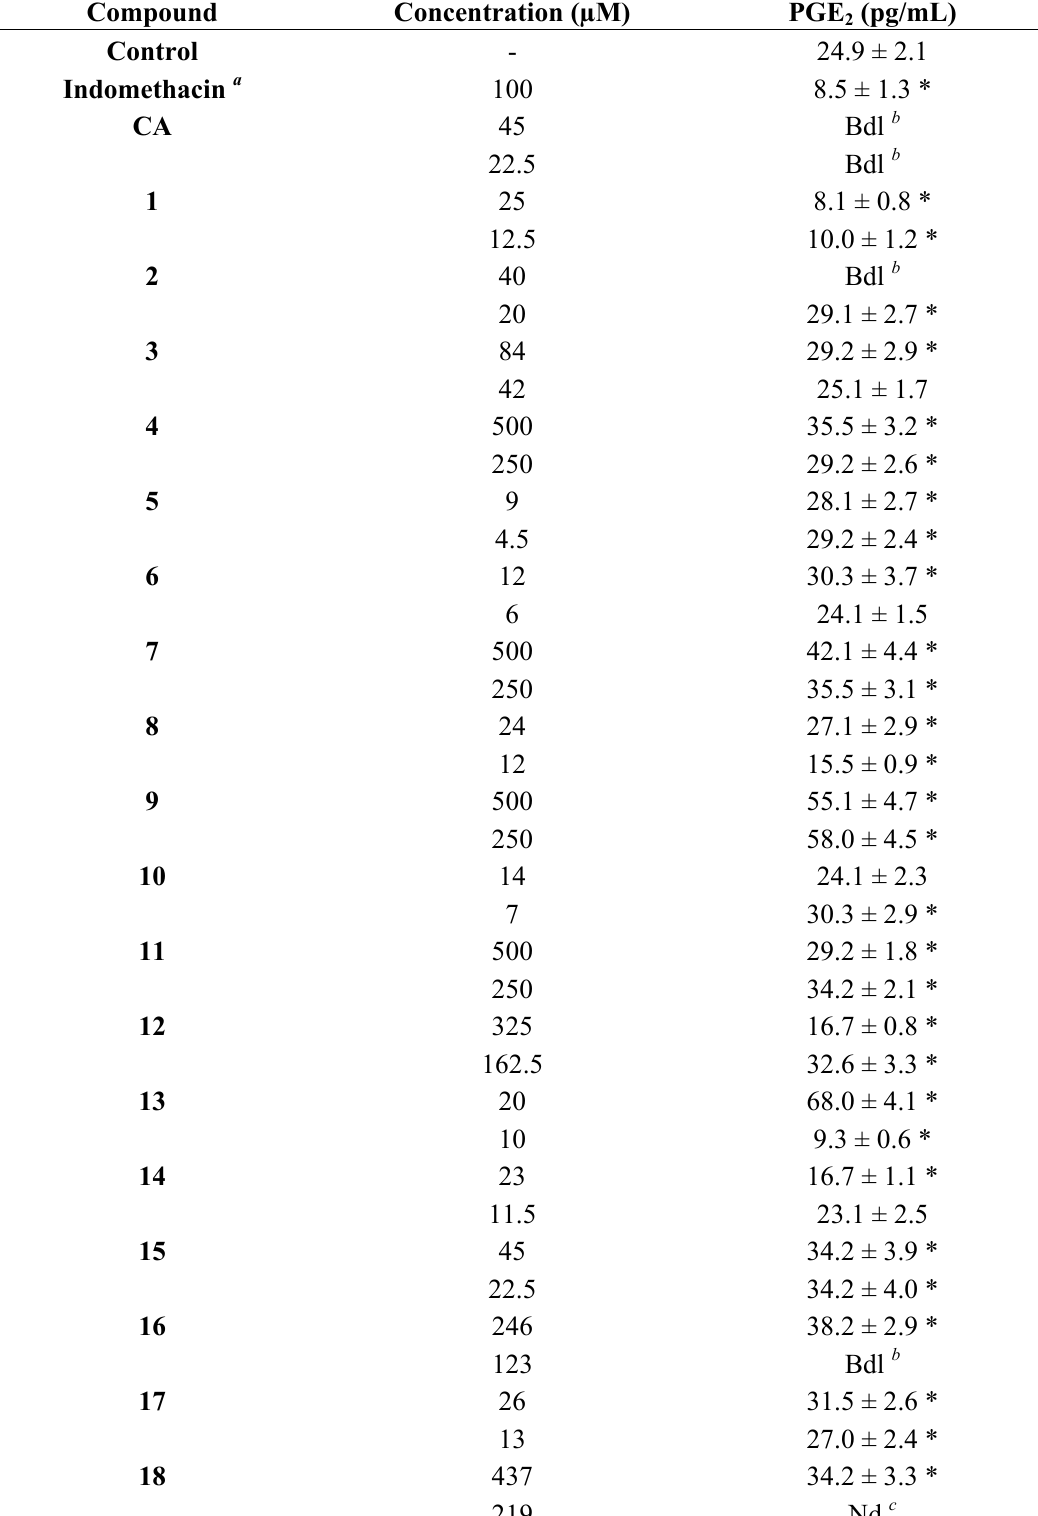
Table 2. Effect of CA and derivatives 1 – 18 on the total PGE AGS cells treated during 1 h with the compounds at 1/2 and 1/4 of IC